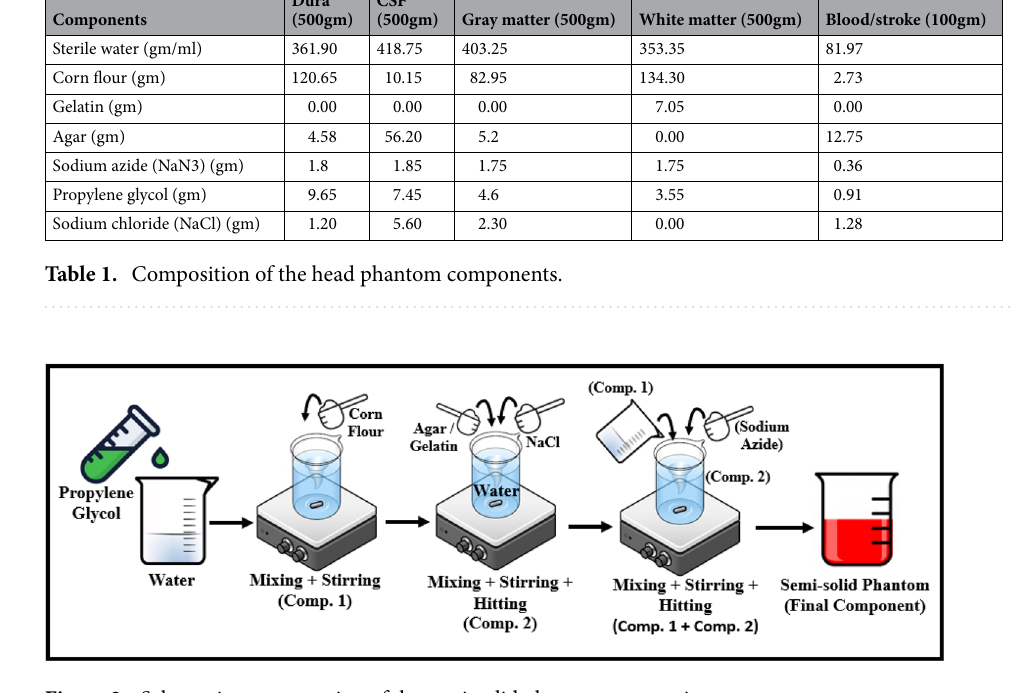
Figure 2. Schematic representation of the semi-solid phantom preparation